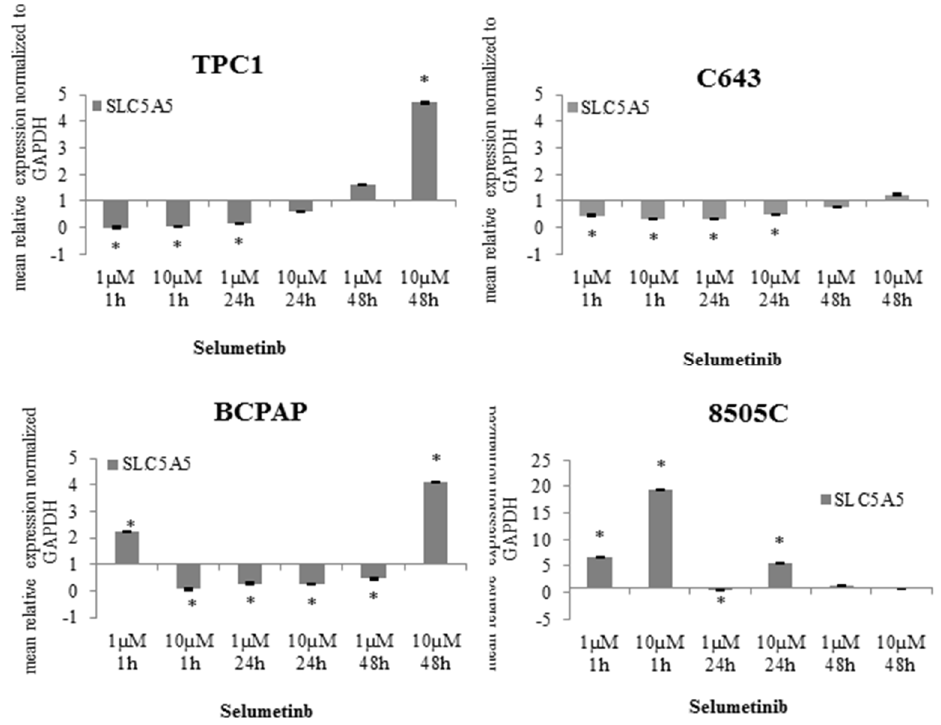
Figure 3. SLC5A5 (sodium iodide symporter (NIS)) expression affected by selumetinib. RT-qPCR of SLC5A5 transcript in TPC1, C643, BCPAP and 8505C cells treated with 1 and 10 µM selumetinib. SLC5A5 transcript was normalized to GAPDH (Glyceraldehyde 3-Phosphate Dehydrogenase). Results are expressed relative to the untreated control. Data represent mean ± SEM of experiments performed in triplicates. * p < 0.05 regarded as significant.